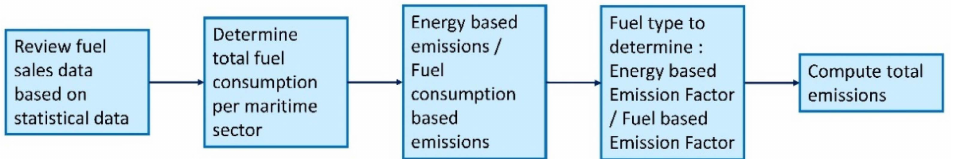
Figure 1. Flowchart that describes the top-down methodology. Emissions are estimated by statistical data of total fuel sales.